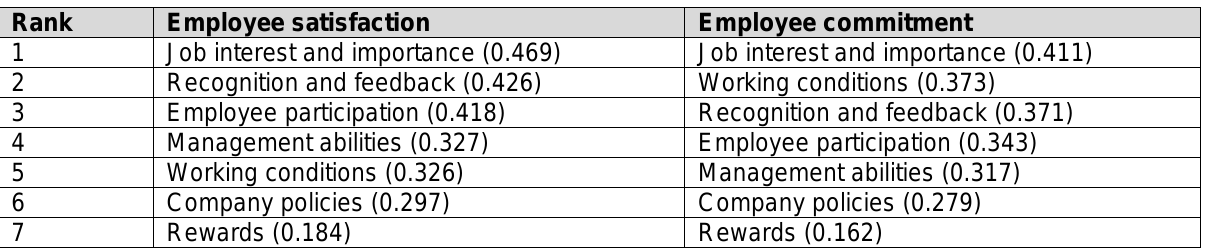
Table 6: Ranking of motivation factors according to correlation strength for employee